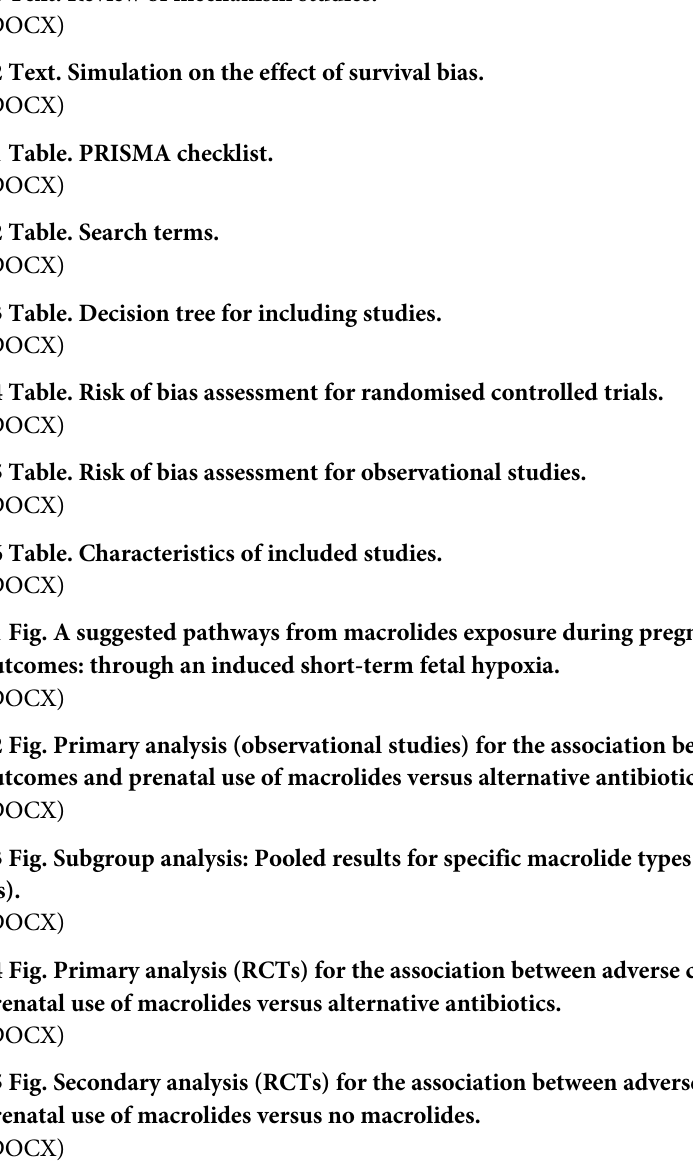
S2 Table. Search terms.